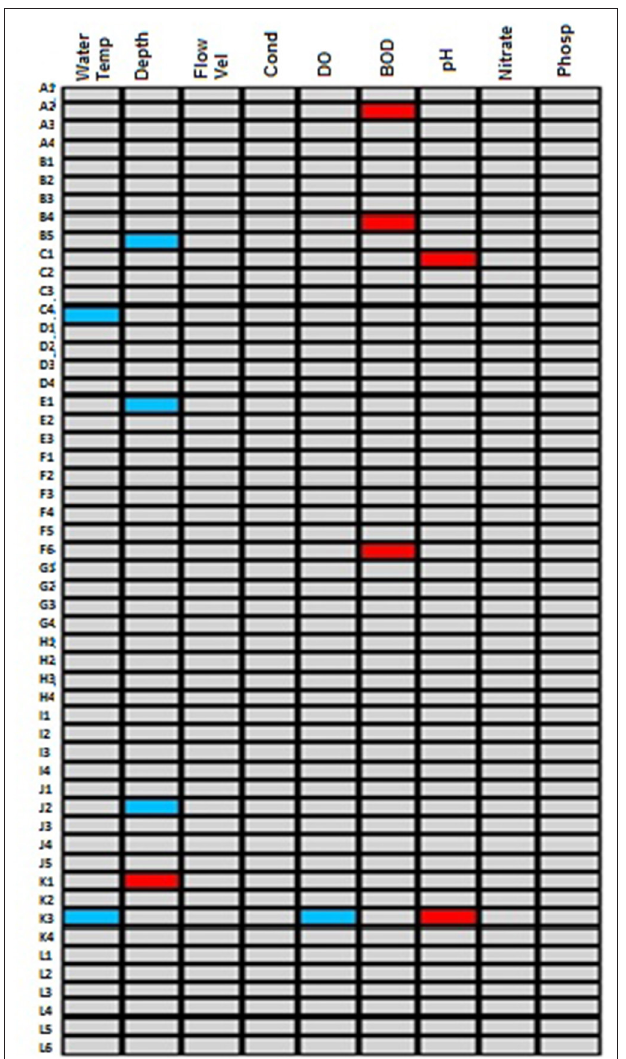
FIGURE 4 | Summary of the fourth-corner test performed for macroinvertebrates traits and physico-chemical variables in the selected riverine systems draining forested catchment. Significant positive relationships are shown in red colored cells while the significant negative correlations are shown in blue colored cells. The gray colored cells represent no-significant